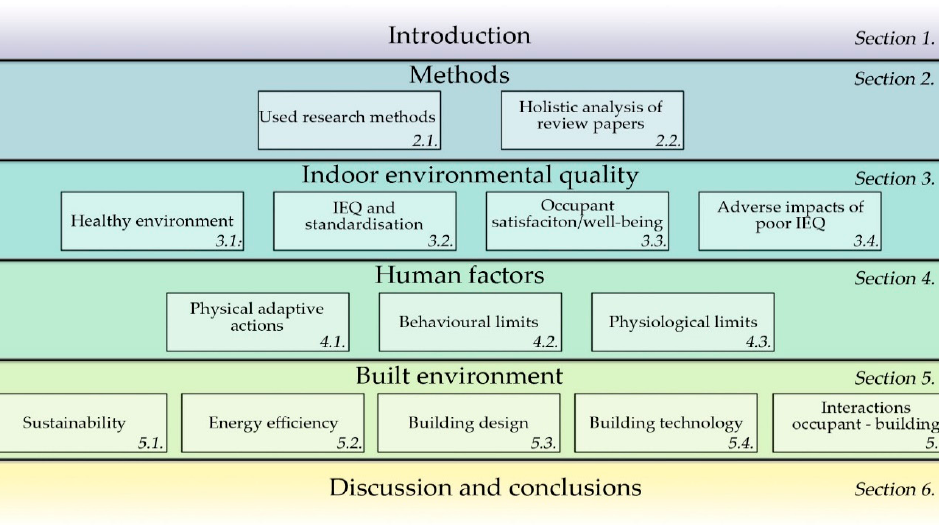
Figure 2. Organization and sections of the review paper.